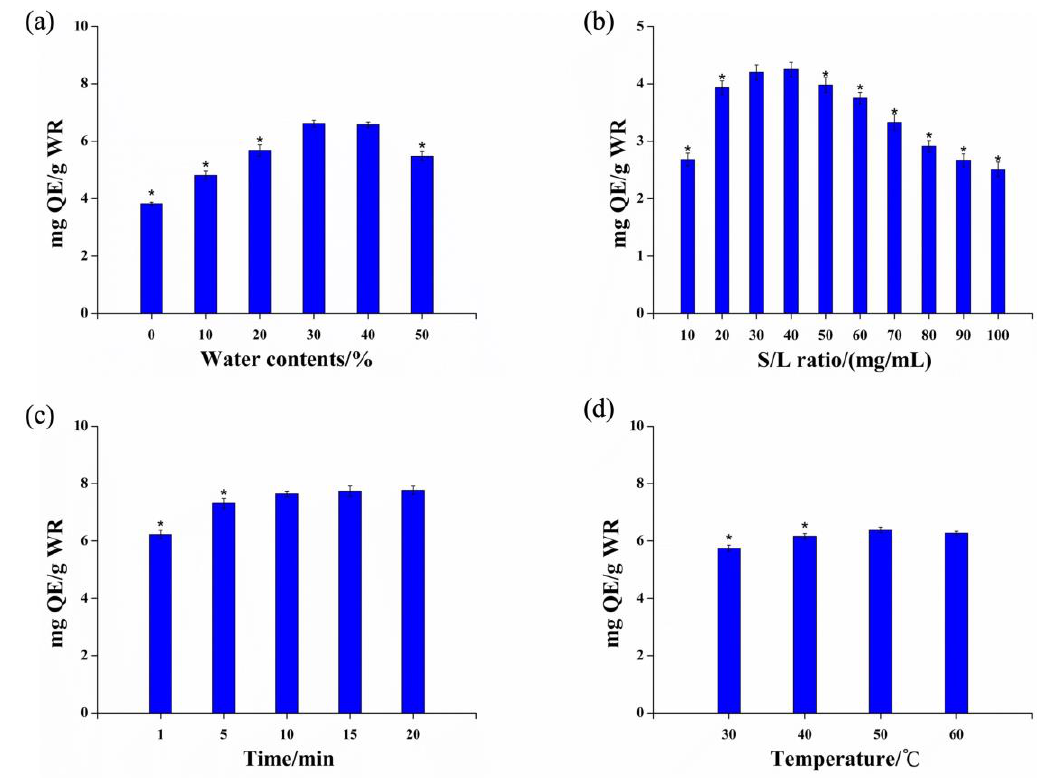
Figure 2. E ff ect of ( a ) water content in DES, ( b ) solid–liquid ratio, ( c ) extraction temperature, Figure 2. Effect of ( a ) water content in DES, ( b ) solid – liquid ratio, ( c ) extraction temperature, and ( d ) and ( d ) extraction time on the extraction extraction time on the extraction yield.